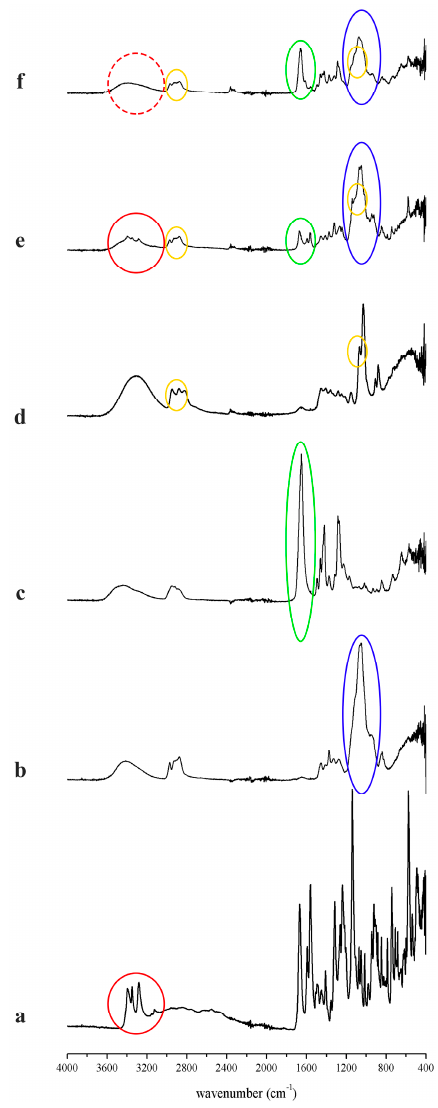
Figure 3. FT-IR spectra of the raw materials, physical mixture and the furosemide containing fibers. ( a ) furosemide; ( b ) HPC EXF; ( c ) PVP 90F; ( d ) trolamine; ( e ) physical mixture (HPC-PVP = 6:4 molar ratio); ( f ) furosemide containing fiber of HPC-PVP = 6:4 molar ratio.